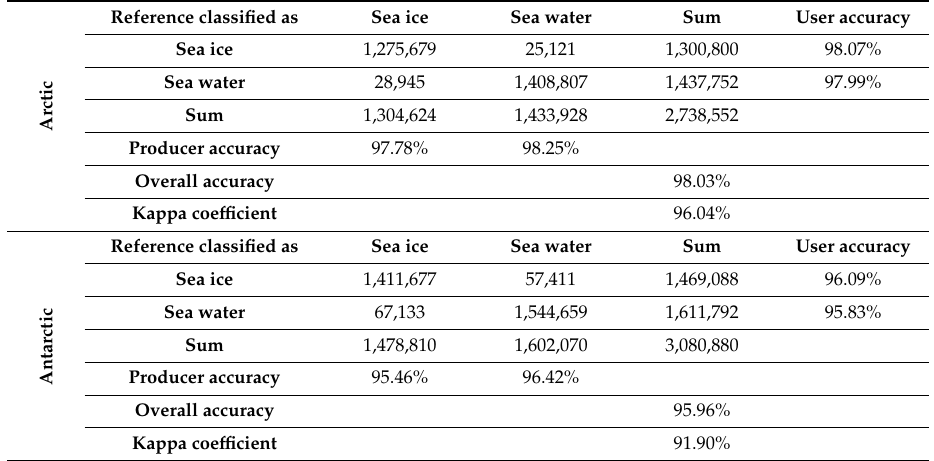
Table 3. The confusion matrix for the Random Forest (RF) algorithm using data from Arctic and Antarctic regions.